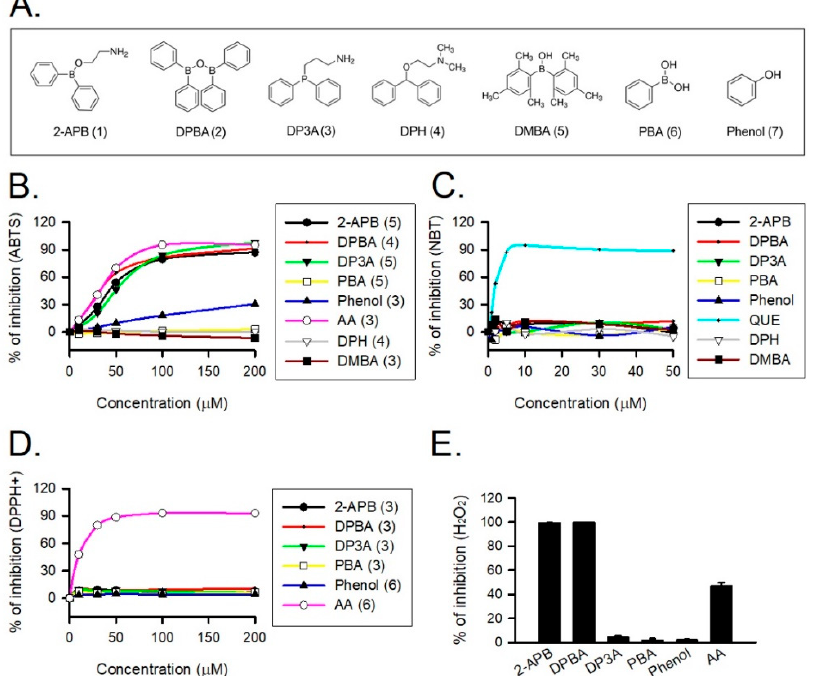
Figure 2. Reactive oxygen species (ROS) scavenging ability of 2-APB and its analogues. ( A ) Structure of 2-APB (compound 1), 2-APB analogues (compound 2–6), and phenol used in this study. ( B ) 2-APB, diphenylborinic anhydride (DPBA), 3-(diphenylphosphino)-1-propylamine (DP3A), and phenol were able to inhibit 2, 2 (cid:48) -azino-bis(3-ethylbenzothiazoline-6-sulfonic acid) (ABTS) radical. Values shown in parenthesis represent the number in each group. ( C ) 2-APB, DPBA, and DP3A were not able to inhibit superoxide anion. ( n = 3). ( D ) 2-APB, DPBA, and DP3A were not able to inhibit DPPH radical. Values shown in parenthesis represent the number in each group. ( E ) 2-APB and DPBA, but not DP3A, were able to inhibit H 2 O 2 . ( n = 3). Abbreviations: AA, ascorbic acid; QUE, quercetin. DPH, diphenhydramine; PBA, phenylboronic acid; DMBA, dimesitylborinic acid.